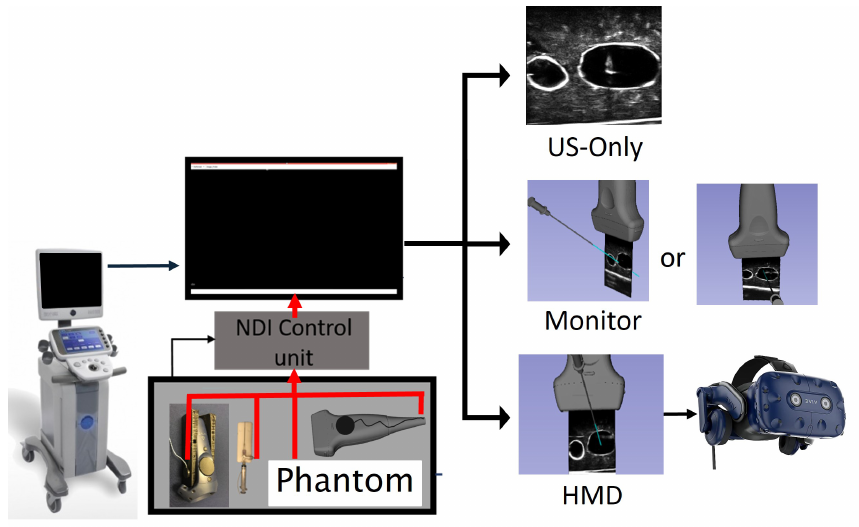
Figure 5. Experimental setup illustrating the hardware used, including the tracking and HMD components, as well as the three modes of